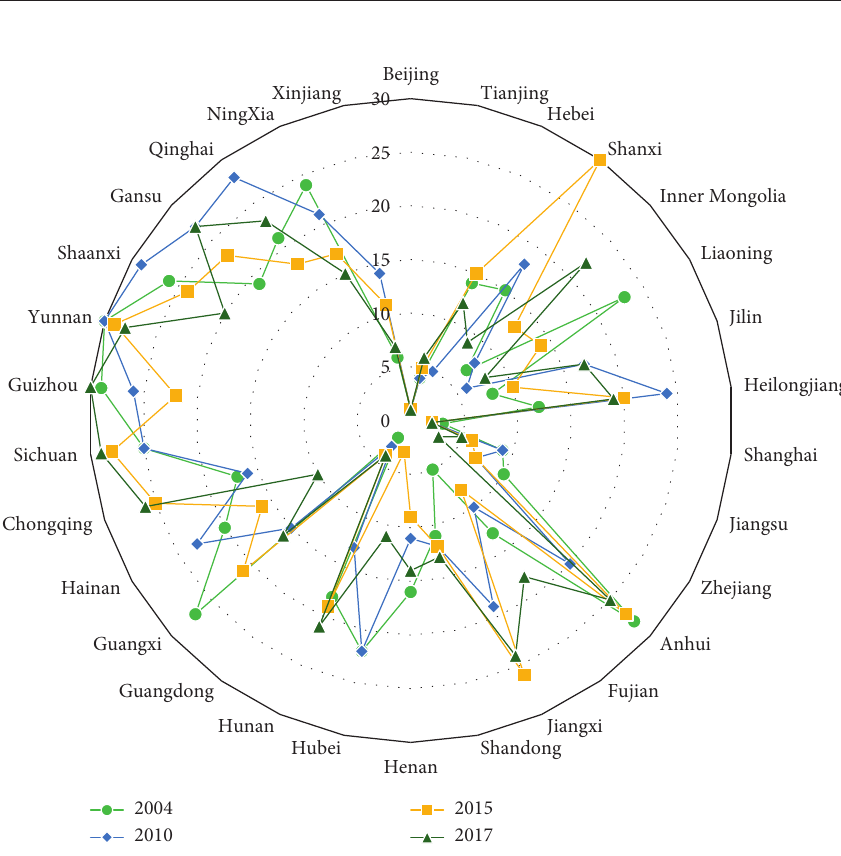
Figure 1: EGQ subsystem ranking in 2004, 2010, 2015, and